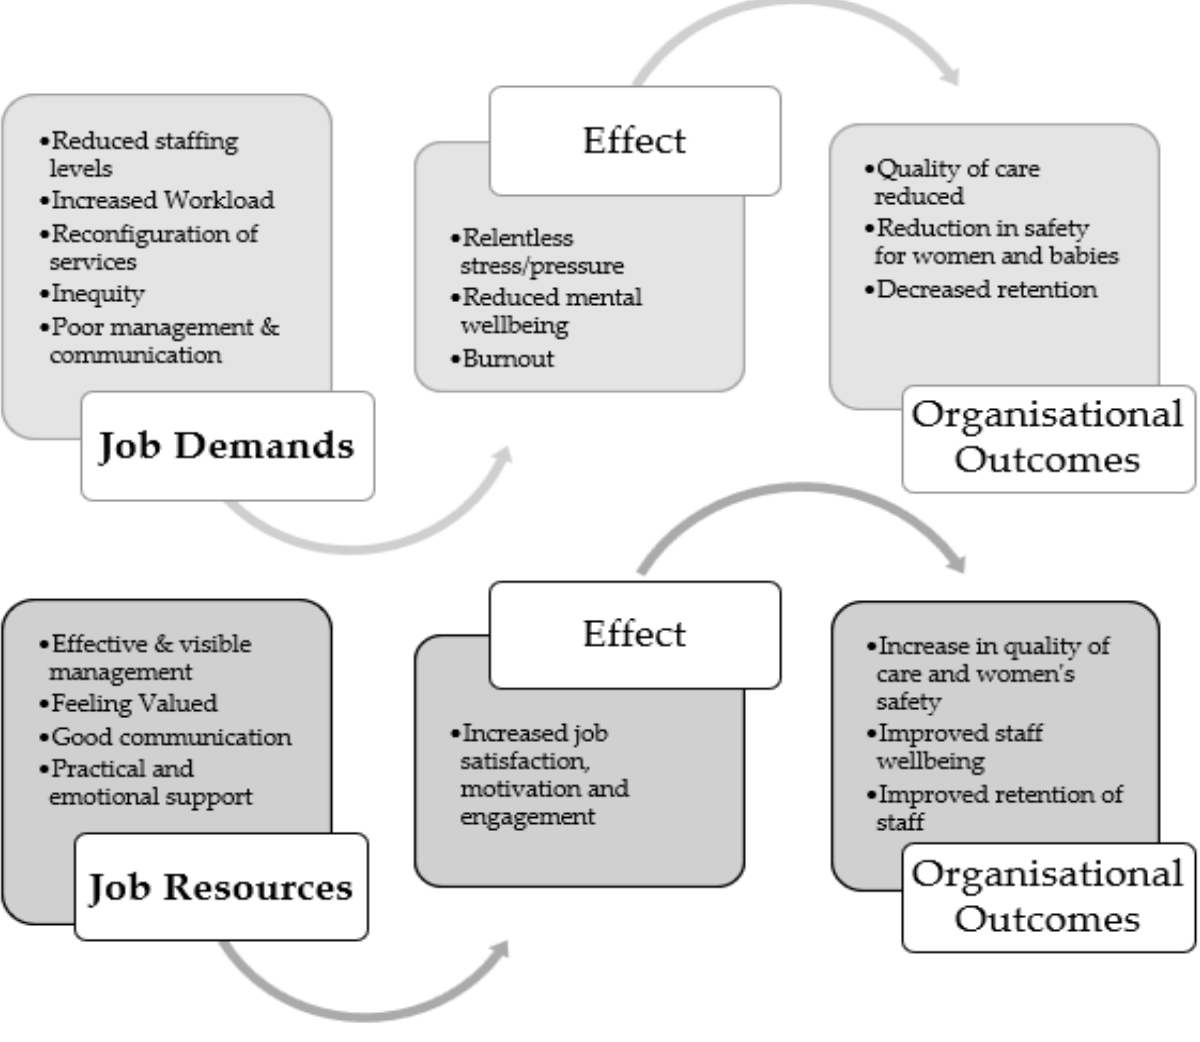
Figure 1. The Job Demands Resources